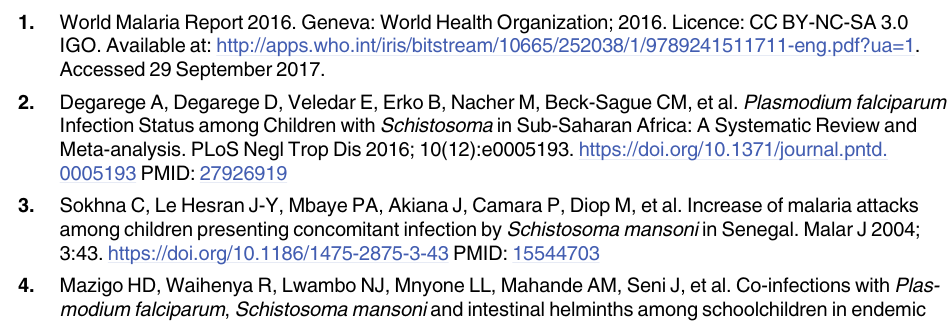
S2 Fig. The numbers of immune cells induced by 50 Schistosoma mansoni -cercariae infec- tion. Female B6 mice (N = 5/group) were infected with 50 S . mansoni -cercariae. (cid:3) P < 0.05, (cid:3)(cid:3) P < 0.01, (cid:3)(cid:3)(cid:3) P < 0.001, Student’s two-tailed t-test. (PDF) S3 Fig. Concentration of IFN- γ in the serum. Female BALB/c mice were inoculated one mil- lion Plasmodium yoelii -parasitized erythrocytes intravenously with or without pre-existing Schistosoma mansoni infection. On day 3 and 4 after inoculation, the concentration of inter- feron-gamma (IFN- γ ) was measured in the serum. Day 3: (cid:3) P < 0.05, t = -2.209, df = 6; Day 4: (cid:3) P < 0.05, t = -2.516, df = 4, Student’s two-tailed t-test.